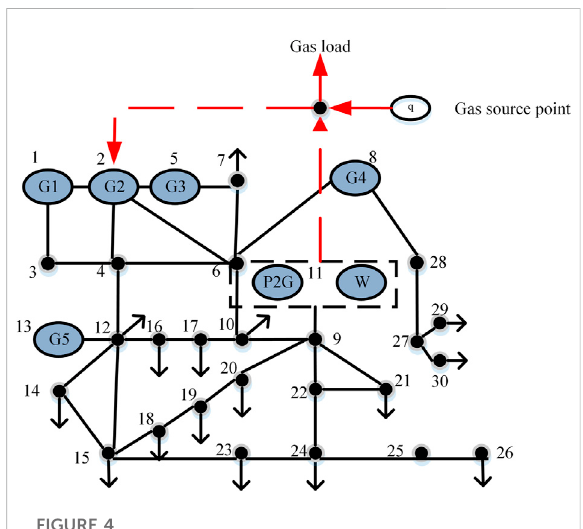
FIGURE 4 Schematic diagram of electric-gas integrated energy